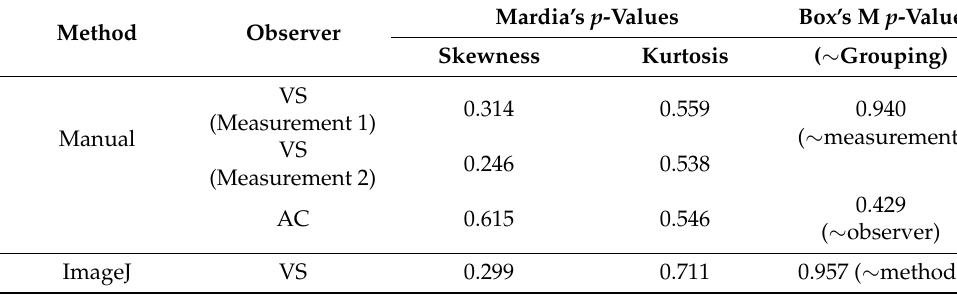
Table 2. Statistical tests for validation of the mixed-effects model